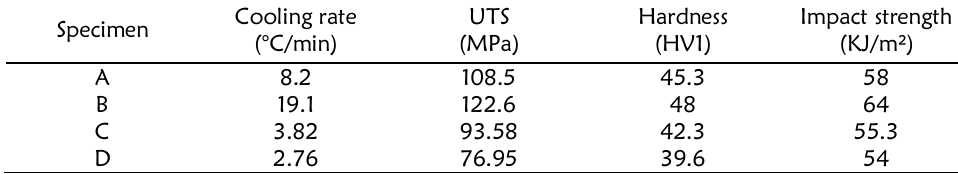
Table 3: Effects of cooling rate on the mechanical